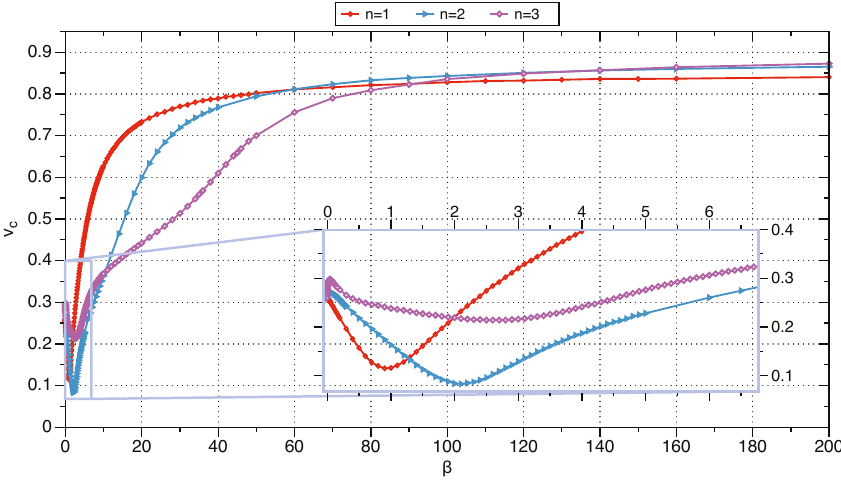
Figure 5 . The critical velocity as a function of (cid:12) in the case of n = 1 ; 2 ; 3.